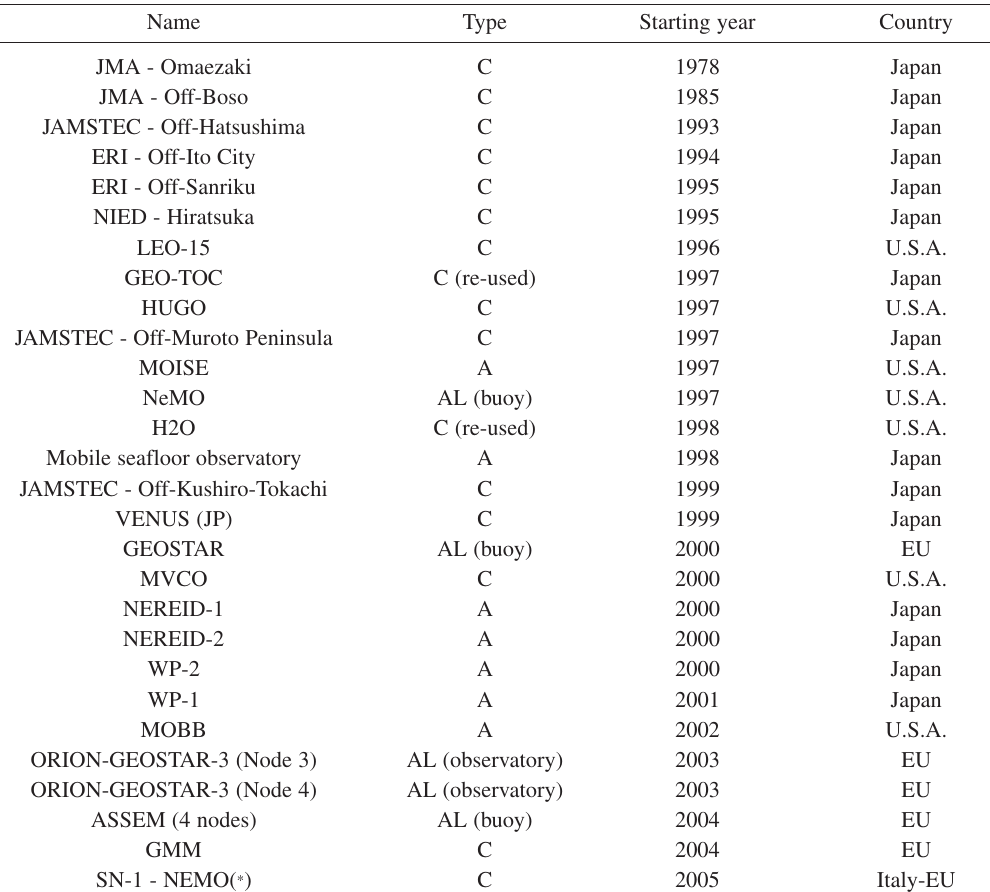
Table III. Twenty-eight seafloor observatories validated at sea; A: autonomous; AL: acoustic linked; C: cabled.